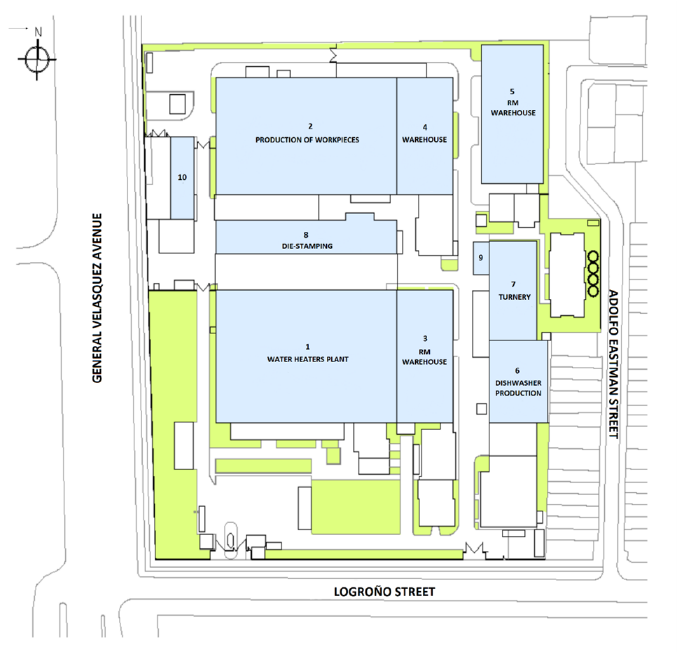
Figure 3. Initial layout of the water heater